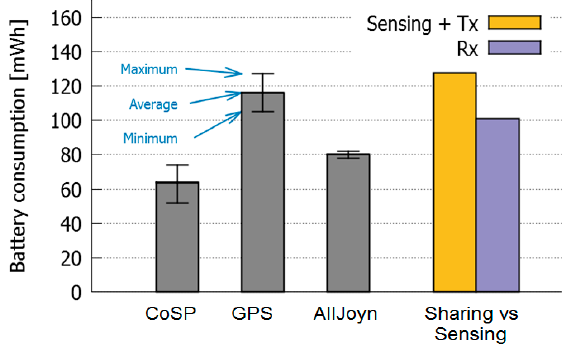
Figure 16. Evaluation of the cost of AllJoyn in a collaborative sensing activity.